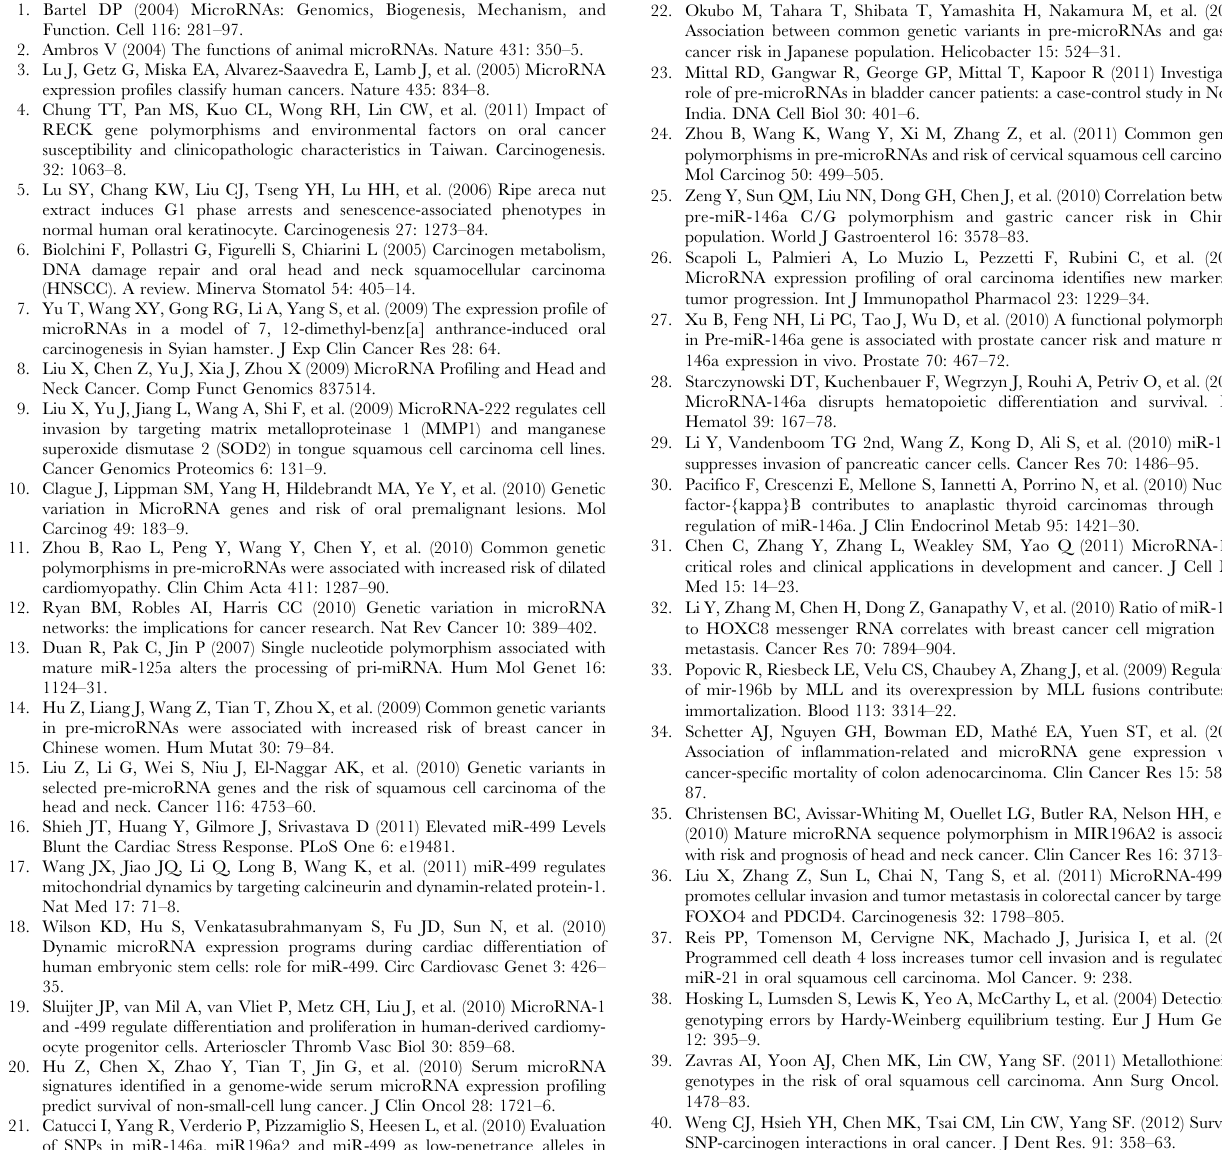
Table S5 Primer sequences and PCR conditions for amplification of miRNA